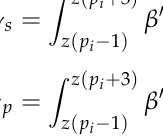
Figure 6. Same with Figure 5 but for daytime results after crosstalk